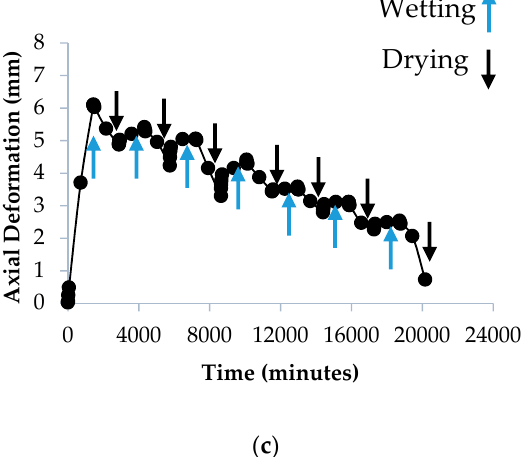
Figure 4. Vertical deformation curve of Yazoo clay sample at ( a ) 3 wet-dry cycles, ( b ) 5 wet-dry cycles, ( c ) 7 wet-dry cycles.